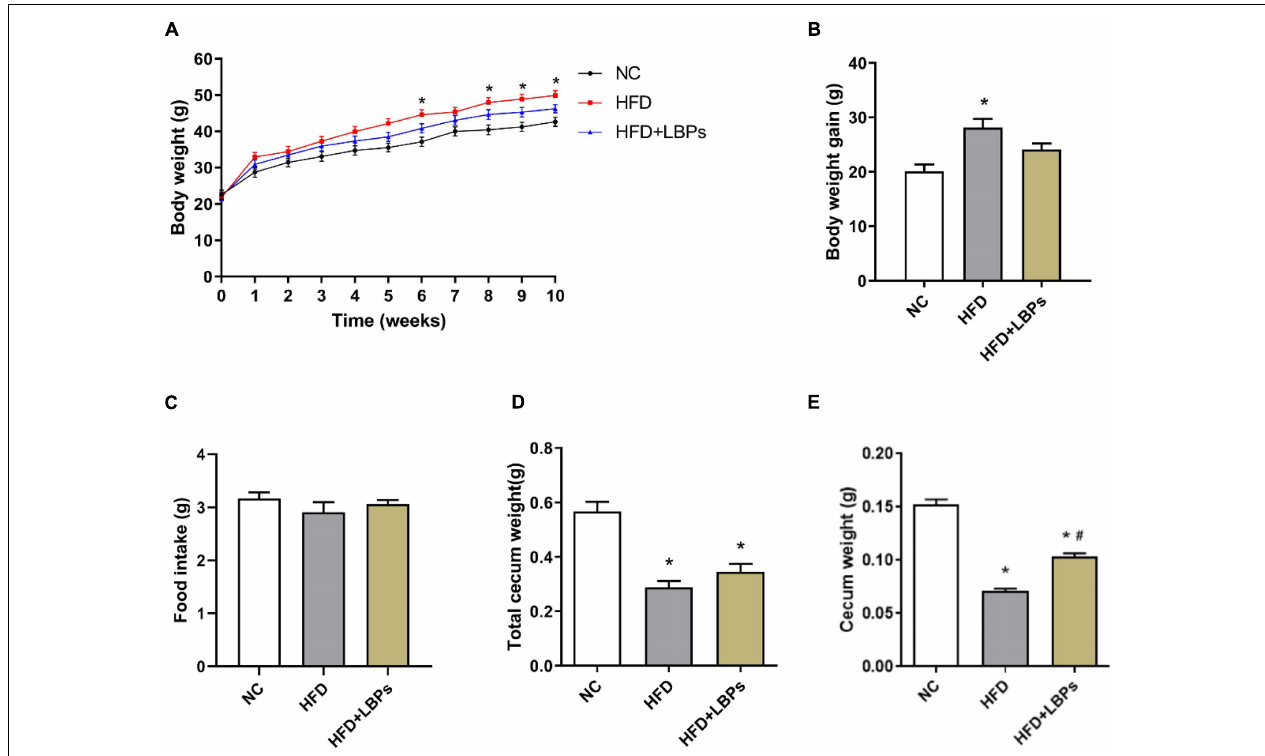
FIGURE 1 | Effects of Lycium barbarum polysaccharides (LBPs) on (A) body weight, (B) weight gain, (C) food intake, (D) total cecum, and (E) cecum tissues in HFD-fed mice. * P < 0.05 vs. NC group and # P < 0.05 vs. HFD